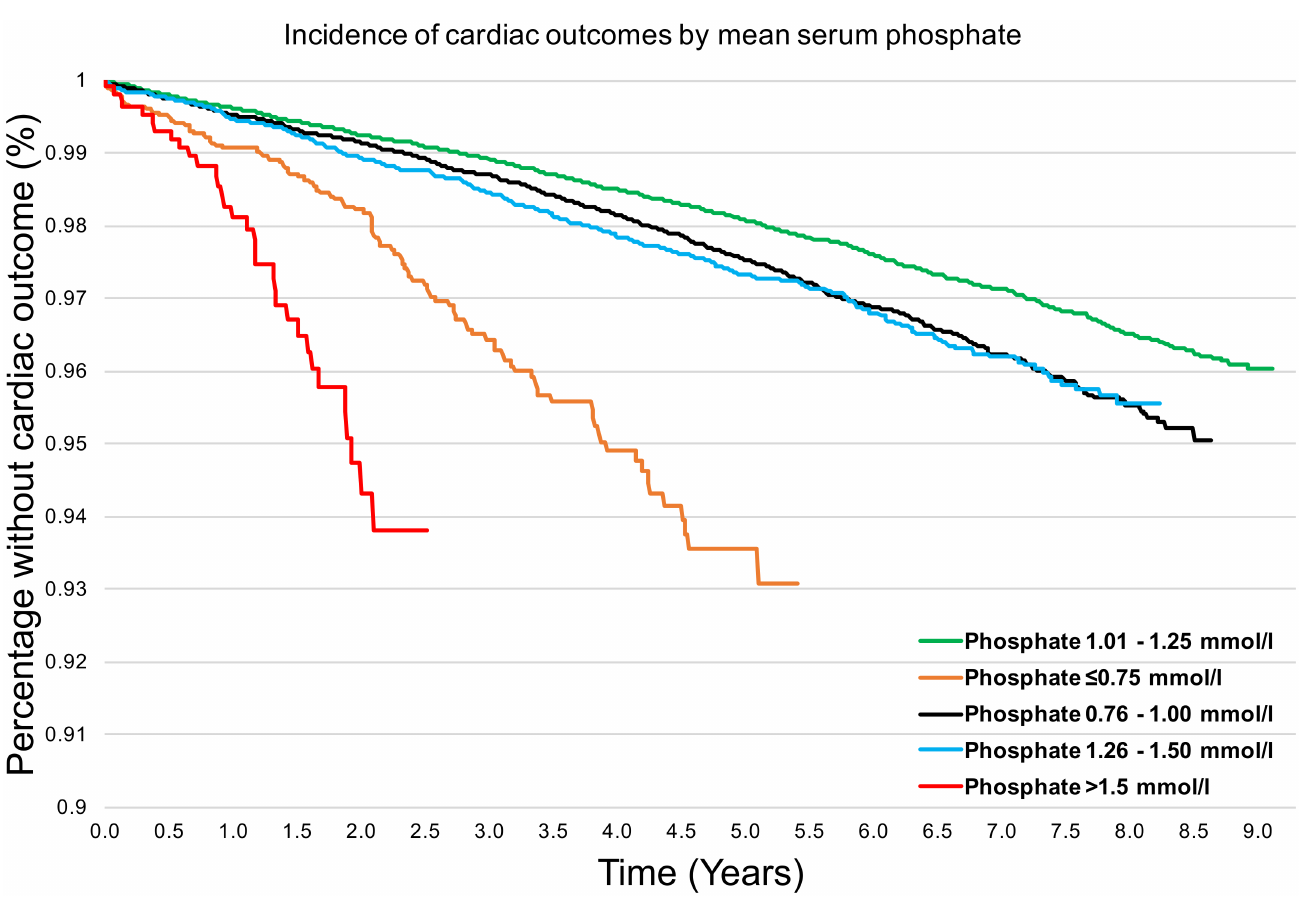
Fig 1. Occurrencesof composite cardiac outcomes by mean phosphate group in all patients (n = 113,993) over time (years). The lowest outcome frequency was associatedwith mid-rangenormophosphatemia (green line). Conversely,serum phosphate that was high, low or at the extremes of normalrange had higheroutcome frequencies. Log rank test for difference betweengroupsp <